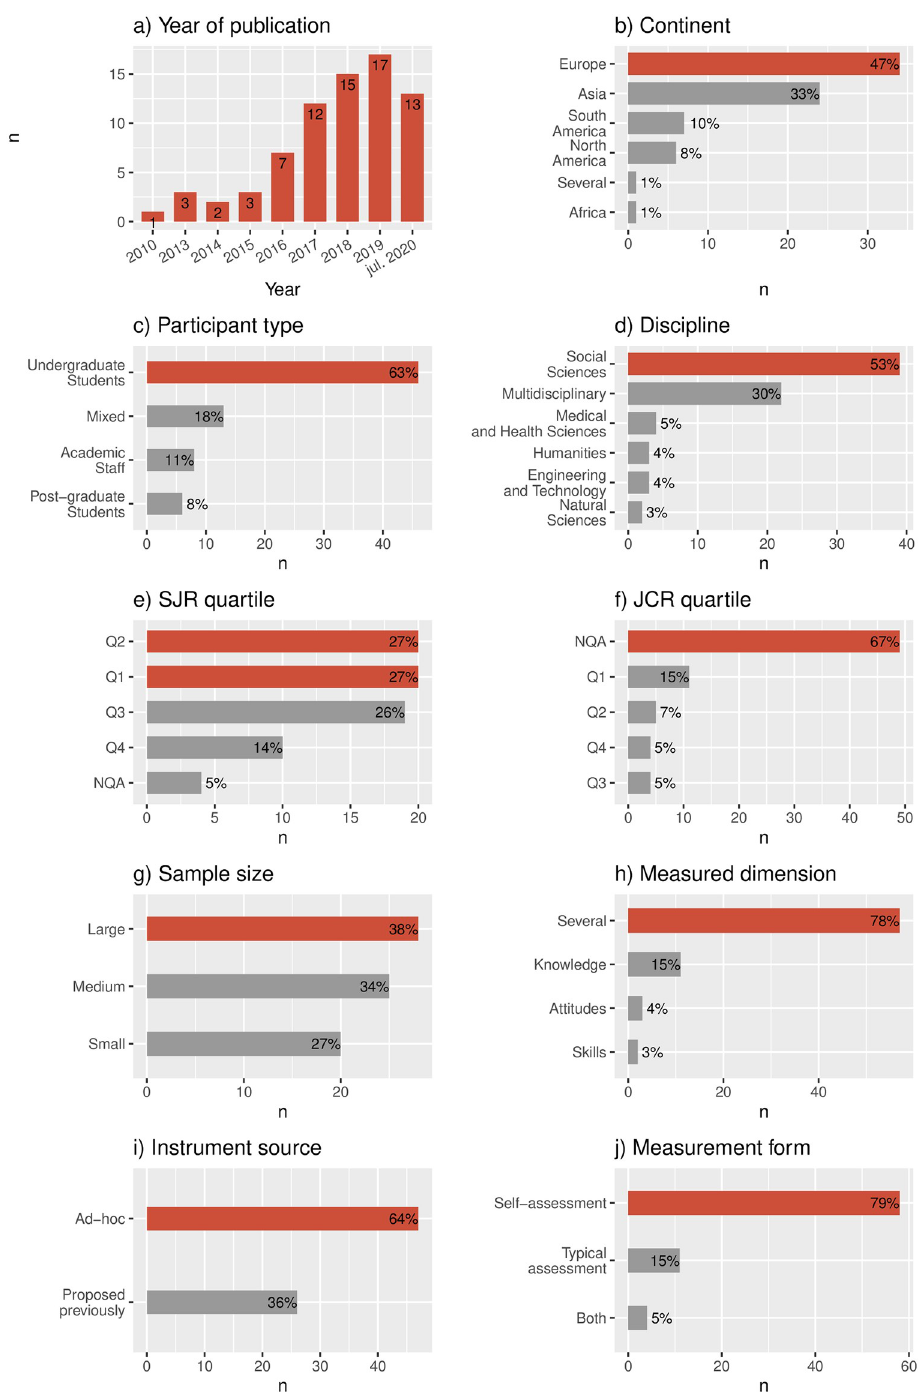
Fig 3. Demographic and methodological features of the